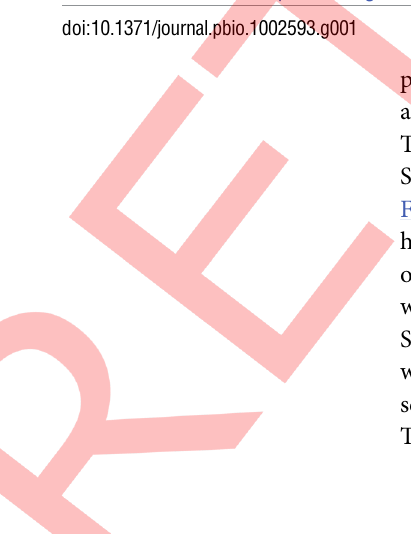
Fig 1. The averagedrelative change in O 2 Hb corresponding to “yes” and “no” sentence interstimuli interval (ISI). (A) Patient F, (B) patient G, (C) patient B, and (D) patient W. (E) Channelconfiguration: Eight sources and eight detectors placedon the frontocentral brain regiontranslated into 20 channels, 10 on each side of each hemisphere. For clearly displayingthe relativechange in O 2 Hb, 10 channels on each side of hemisphere were further subdivided in groups of 5 channels—i.e., 20 channelswere dividedinto four groups, each consistingof 5 channels. In each subplot, the x -axis is time in seconds and the y -axis is relative changein O 2 Hb, and the five different coloredlines correspond to relative changein O 2 Hb across 5 different channels,as depictedin the channelconfiguration map. Fig 1 data is locatedat https://doi.org/10.5281/zenodo.192386;https://doi.org/10. 5281/zenodo.192388; https://doi.org/10.5281/zenodo.192390;